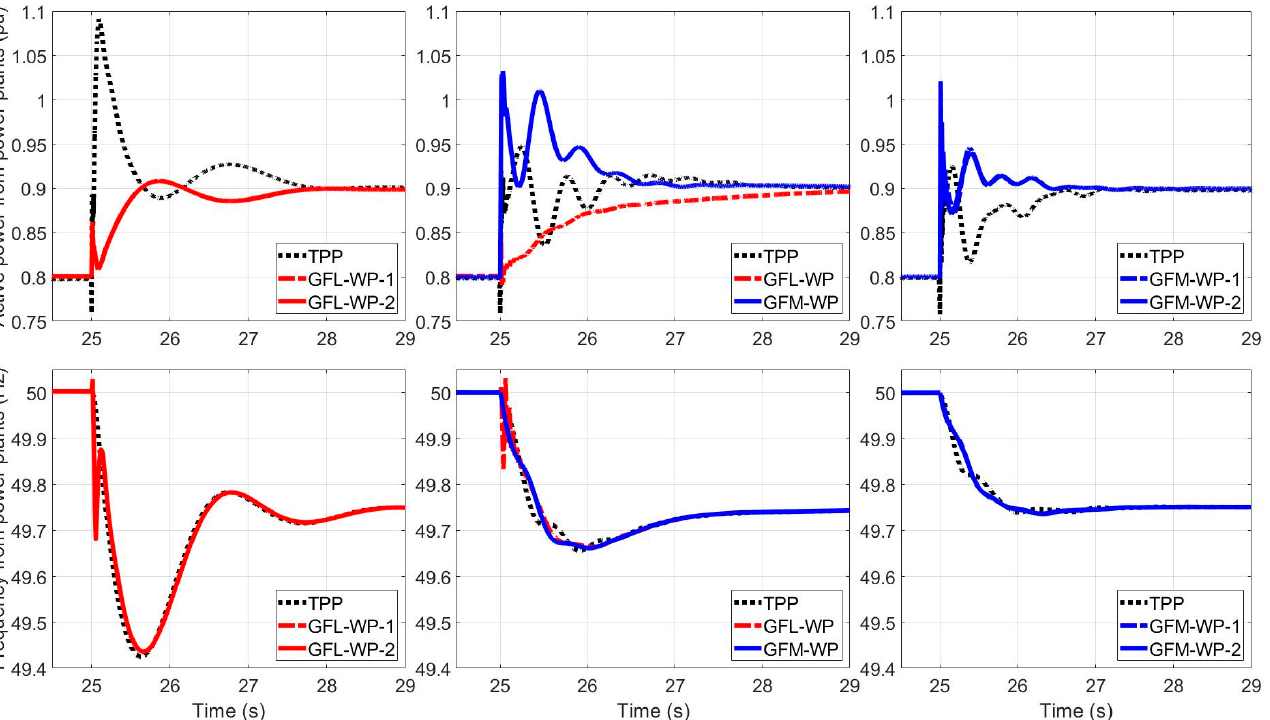
Figure 7. Comparison of GFL-FCM and GFM-FCM on FFR. 1st column: scenario (i) one TPP with two GFL-WPs; 2nd column: scenario (ii) one TPP with one GFL-WP and one GFM-WP; 3rd column: scenario (iii) one TPP with two GFM-WPs.